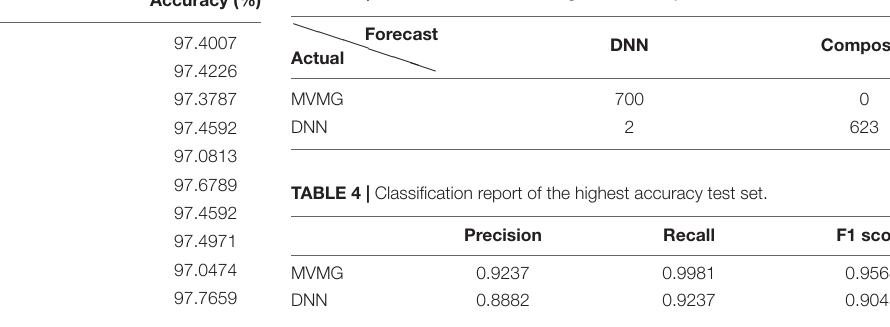
TABLE 3 | Confusion matrix of the highest accuracy test set.